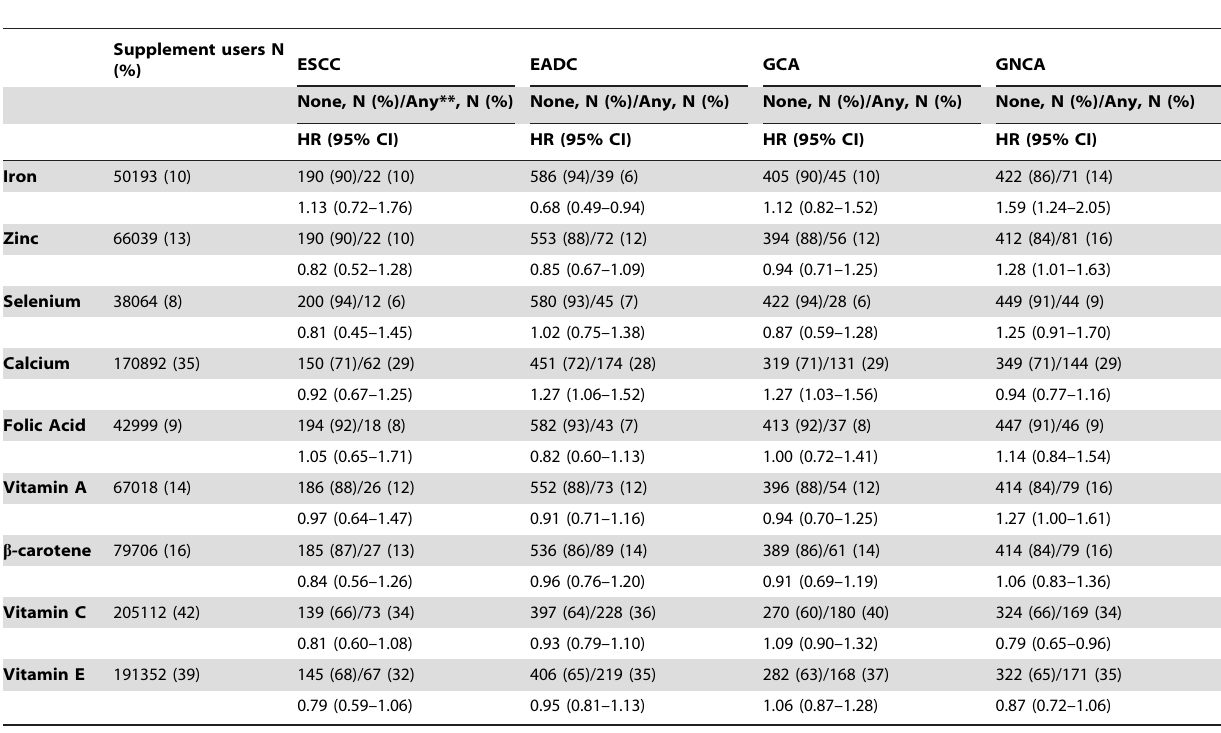
Table 3. Adjusted* hazard ratios (HR) and 95% confidence intervals (CI) for use of individual vitamin or mineral supplements for four upper gastrointestinal cancers in the NIH-AARP Diet and Health Study cohort.